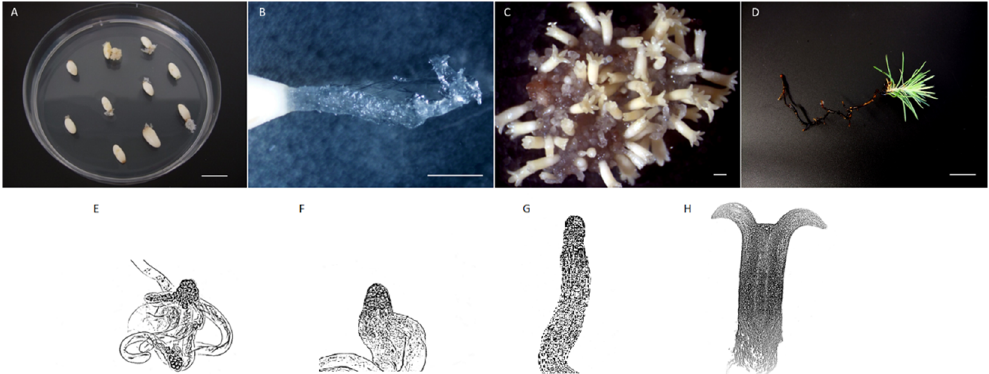
Figure 1. Somatic embryogenesis steps in Pinus pinaster . ( A ) Initiation of embryogenic cultures from immature zygotic embryos enclosed within the megagametophyte and cultured on a medium containing 2,4—dichlorophenoxyacetic acid and N 6 —benzyladenine. ( B ) Embryogenic masses (EMs) protruding through the micropyle. ( C ) Late development and maturation of cotyledonary somatic embryos achieved through the removal of plant growth regulators (PGRs), the increase in the sucrose and gelling agent concentrations, and the addition of abscisic acid (ABA). ( D ) Germination and acclimatization of plantlets. ( E – H ) Representation of different developmental stages across embryo differentiation. The absence of PGRs triggers the differentiation of EMs ( E ) into the early embryos ( F ) and, subsequently, into the late embryos ( G ), which have a translucent embryo proper in the apical part and an elongated suspensor in the basal part. Afterwards, reduction in water availability and ABA treatment promotes the formation of cotyledonary embryos and their maturation. Mature embryos ( H ) are prominent and opaque embryos proper, with a manifest procambium, a well-established shoot apical meristem surrounded by a whorl of cotyledons and a well-defined root apical meristem. The suspensor cells disappear as a result of programmed cell death during late differentiation. Bar 1 cm ( A , D ), 1 mm ( B , C ). Source: unpublished images from the authors.